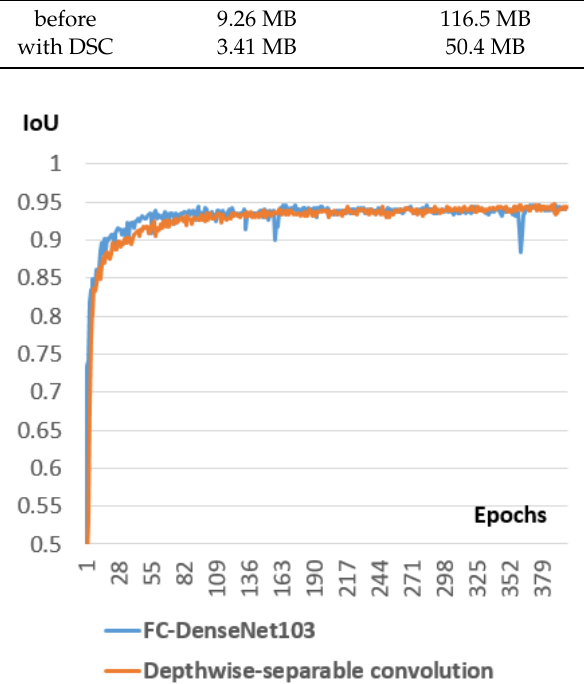
Figure 16. Intersection of Union (IoU) before and after adding DSC on FC-DenseNet103 network